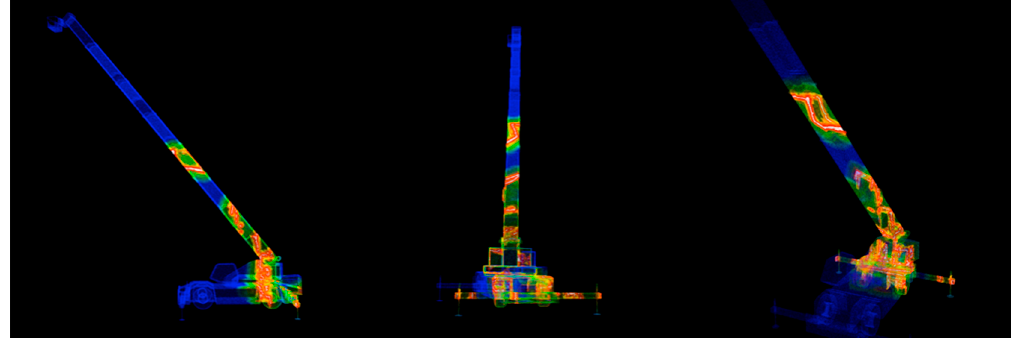
Figure 19. Transparent collision visualization result of the crane vehicle without showing the point cloud of the plant.